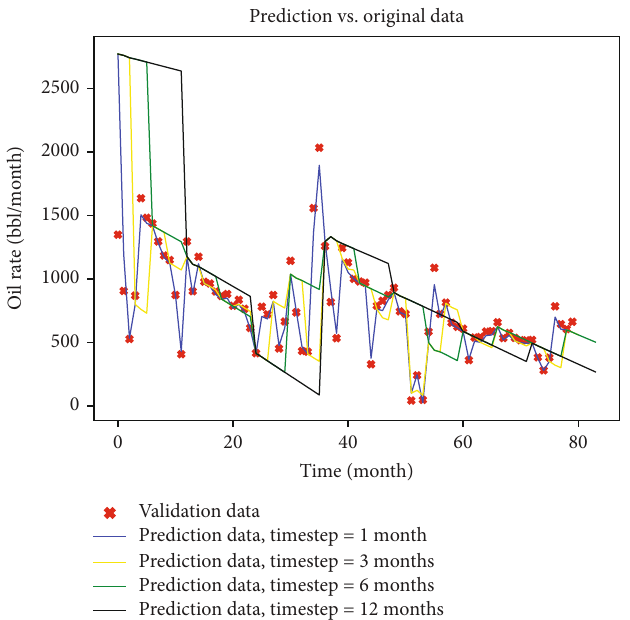
Figure 16: Comparisons between oil rate data with predicted data as the function of timesteps.